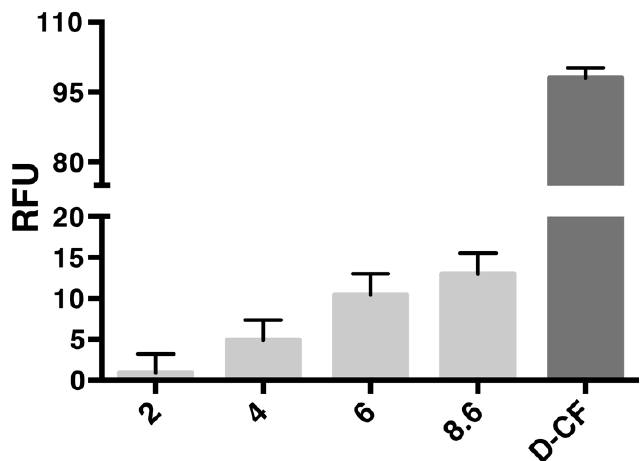
Figure 1. Screening of liposome concentration for CF expression of AqpZ-sGFP. The final concentrations of lipids were indicated with numbers below the bar chart. The reaction mixture with 8.6 mg / mL final lipid concentration without the AqpZ-sGFP plasmid template was used as the negative control. D-CF sample was used as positive control. RFU, relative fluorescent unit.